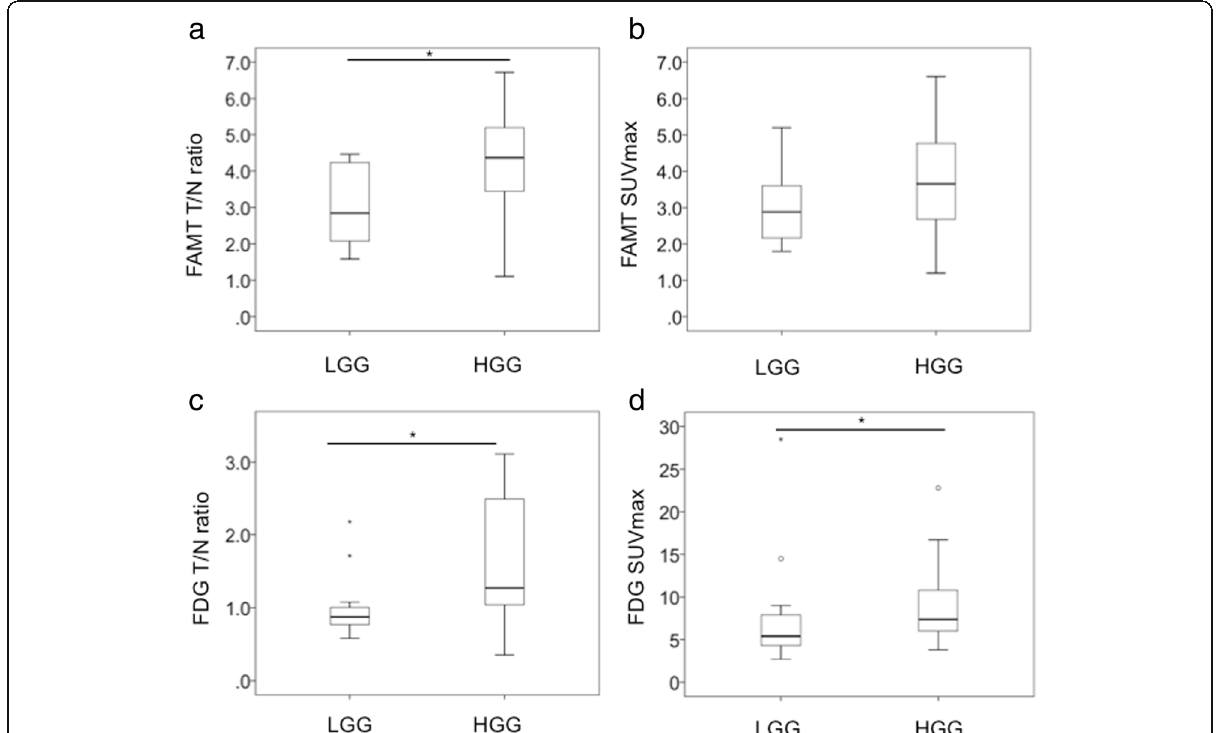
Fig. 1 Box-and-whisker plots of 18 F-FAMT and 8 F-FDG uptake for LGG and HGG. a The difference in T/N ratio of 18 F-FAMT uptake between LGG and HGG was significant ( p = 0.006). b The difference in SUV max of 18 F-FAMT uptake between LGG and HGG was not significant ( p = 0.087). c , d The differences in T/N ratio and SUV max of 18 F-FDG uptake between LGG and HGG were significant ( p = 0.016 and p = 0.033,